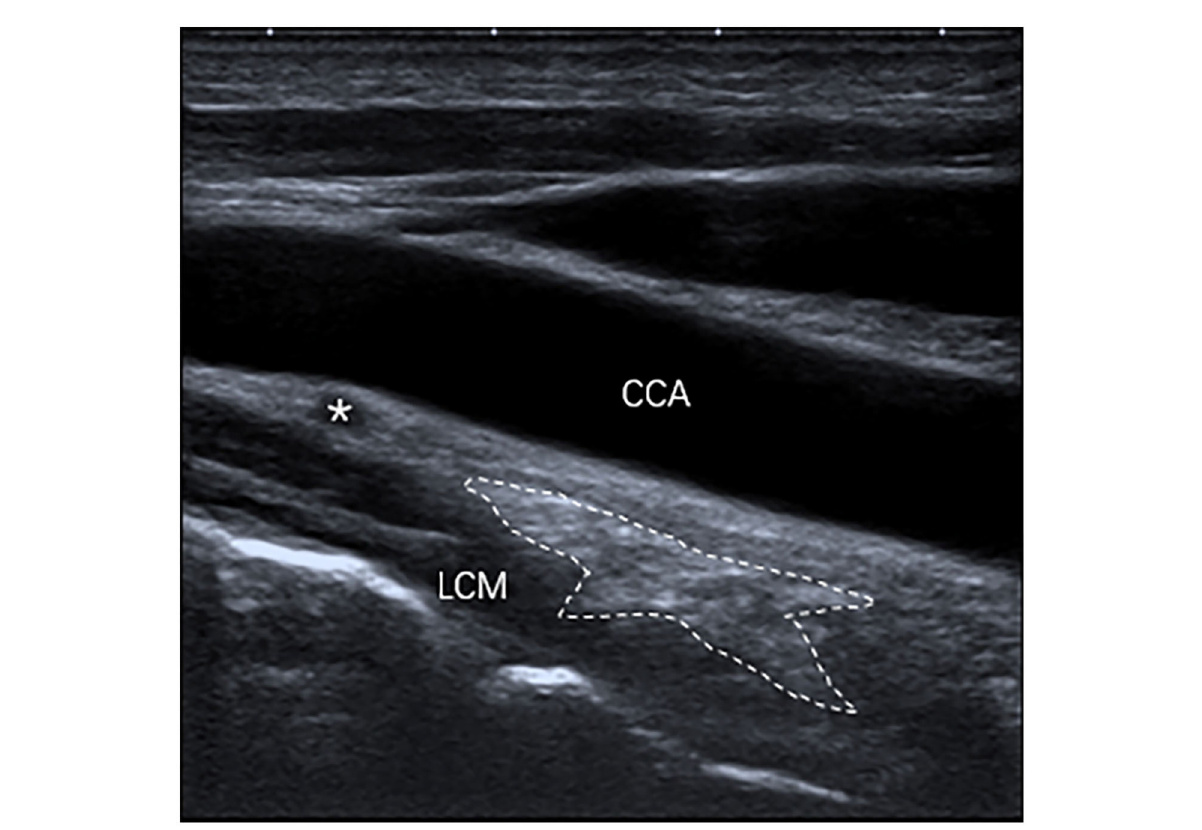
FIGURE5 The SG, with a star shape (outlined) and hyperechogenicity, was located between the common carotid artery (CCA) and the longus colli muscle (LCM) and was under the inferior thyroid artery (*) on the longitudinal ultrasound image.